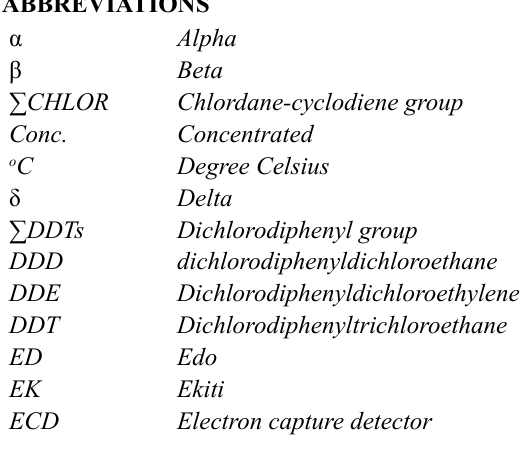
OCPs; TOC = total organic carbon; 1 and 2 = young and old plantation